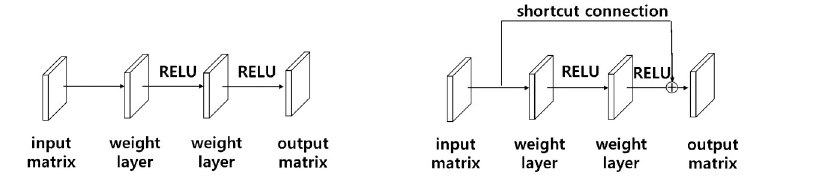
Fig 6. Residual learning. (a) Stacked layers (b) Stacked layers using a shortcut connection.